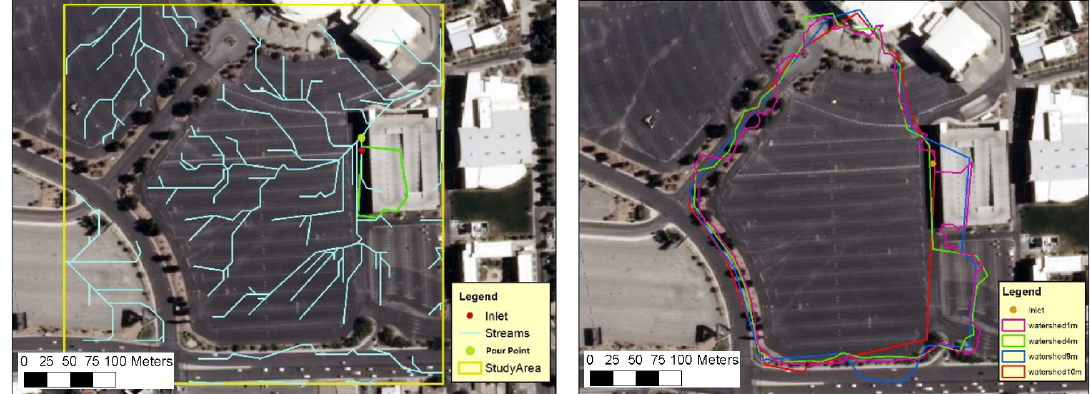
Figure 7. Stream network constructed using 1 m DEM for the Blacklot is shown ( on the left ), while watersheds for the inlet generated from different DEMs are shown ( on the right